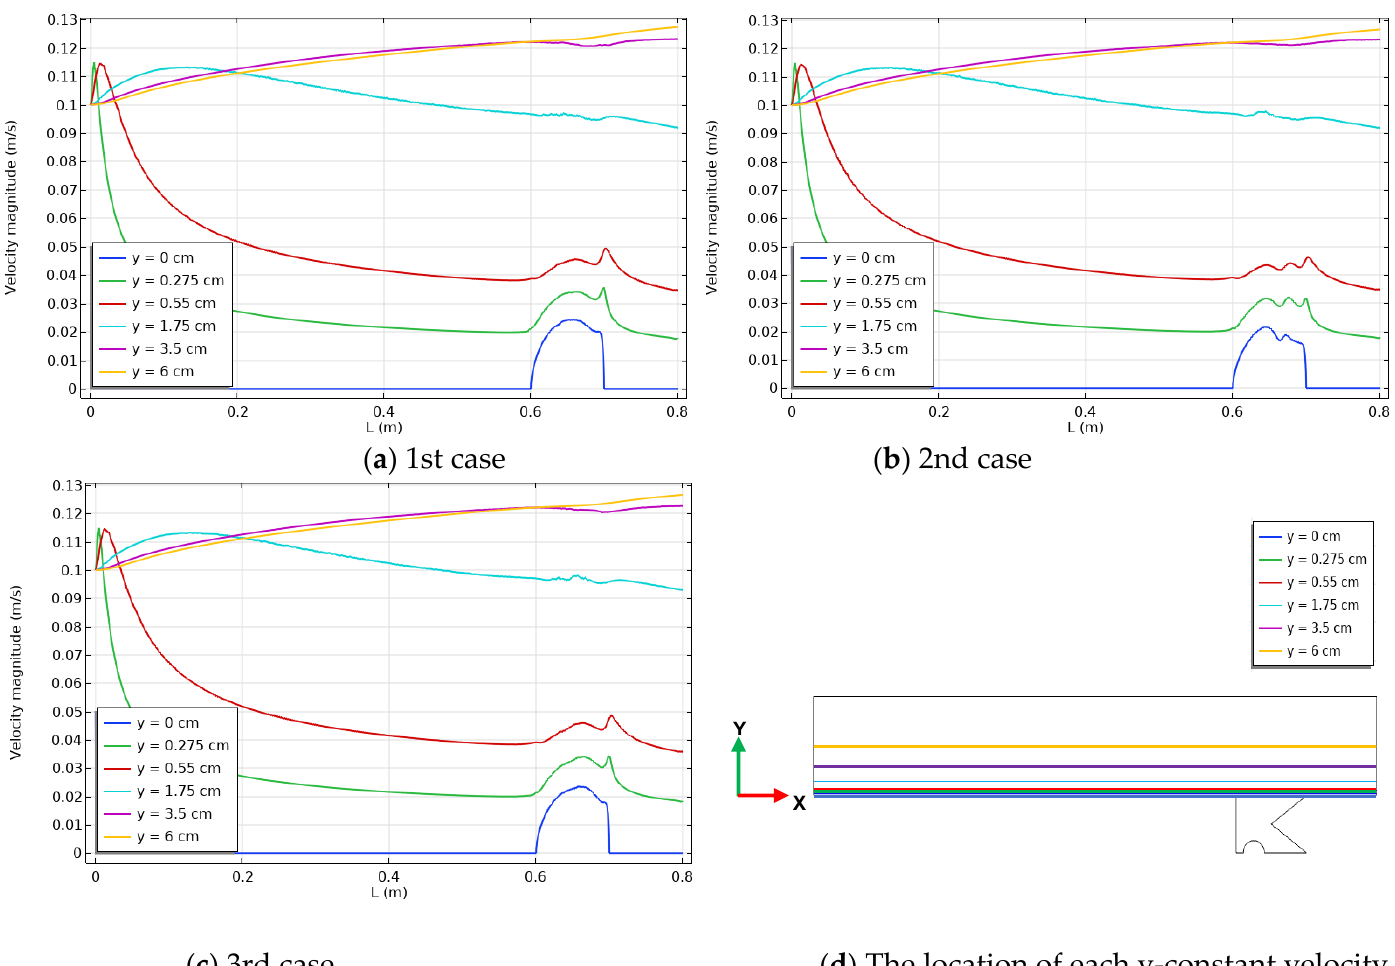
Figure 7. Velocity distribution during the positive y axis in the assembly .